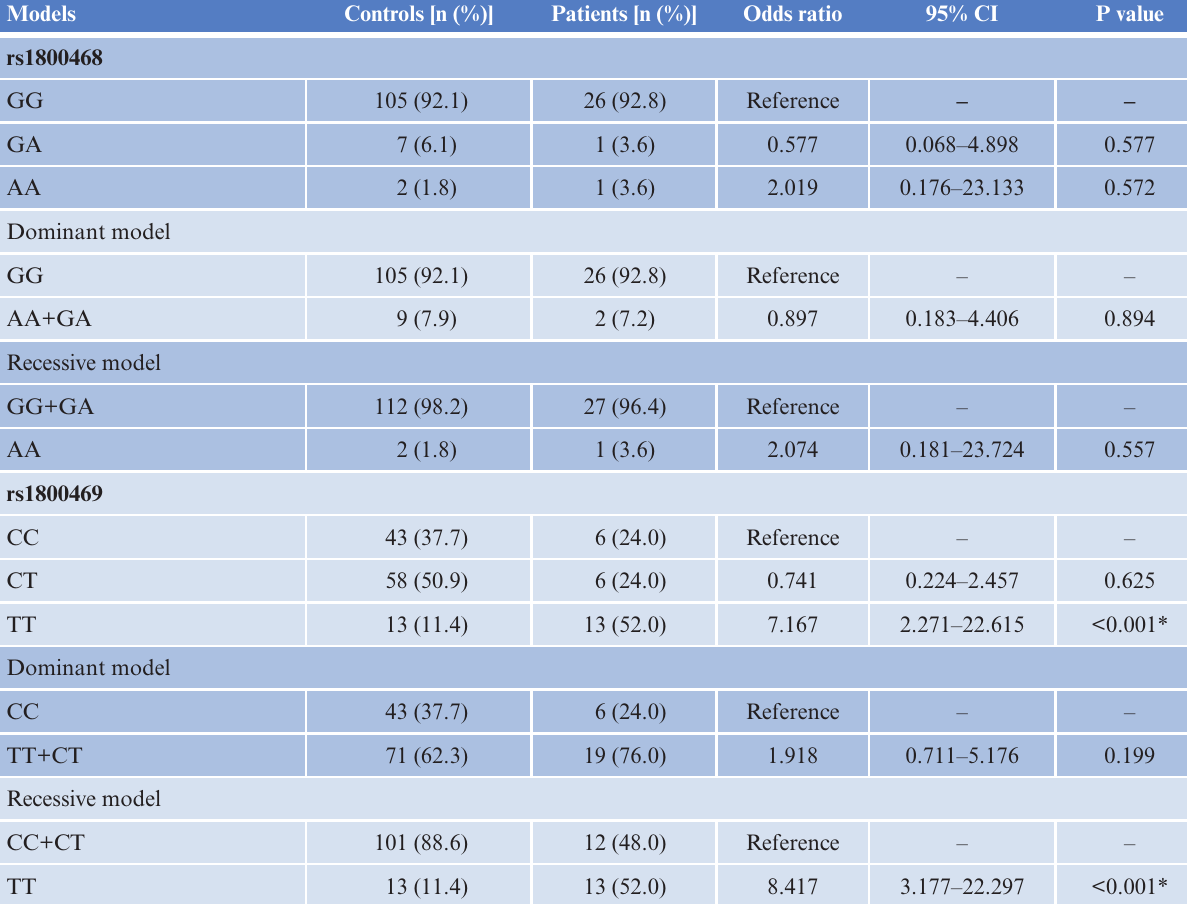
Table 1: Genotypic frequencies in WT and control patients and case-control study for TGFB1 promoter region polymorphisms (rs1800468 and